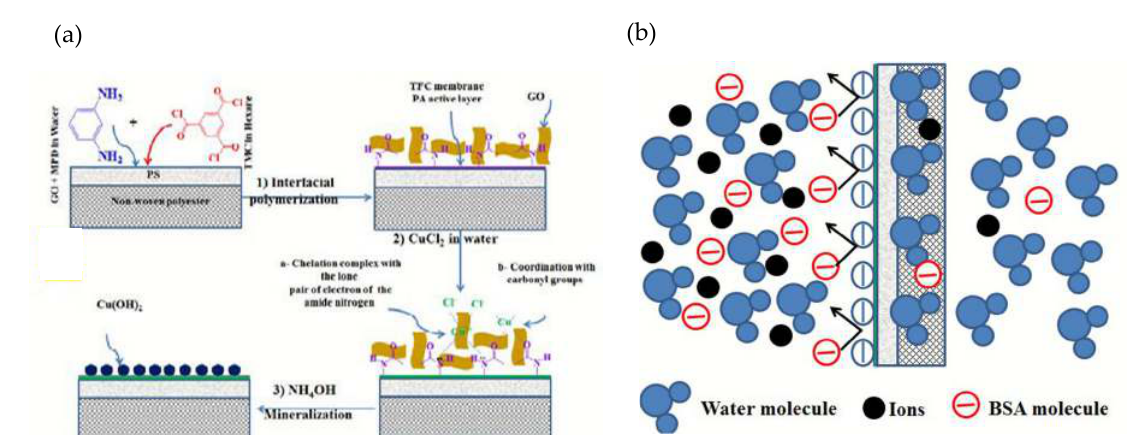
Figure 6. ( a ) Schematic representation of the IPP and mineralization of TFC-RO membrane with formation of Cu(OH) 2 surface modification; ( b ) Mechanism of electrostatic repulsion between BSA and membrane surface. Extracted and adapted from [141].